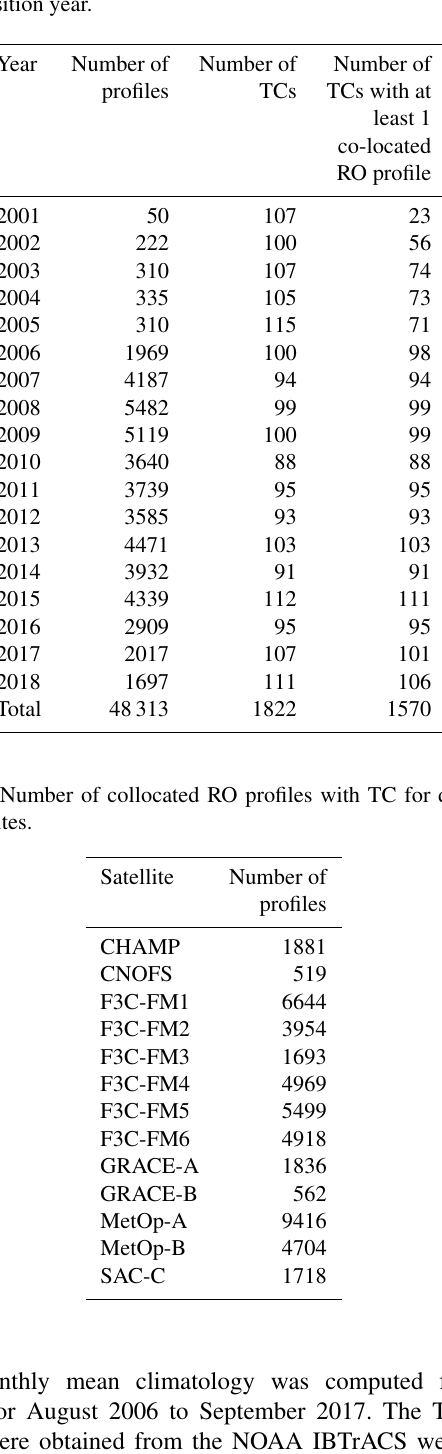
Table 4. Number of collocated RO profiles with TCs with regard to the acquisition year.